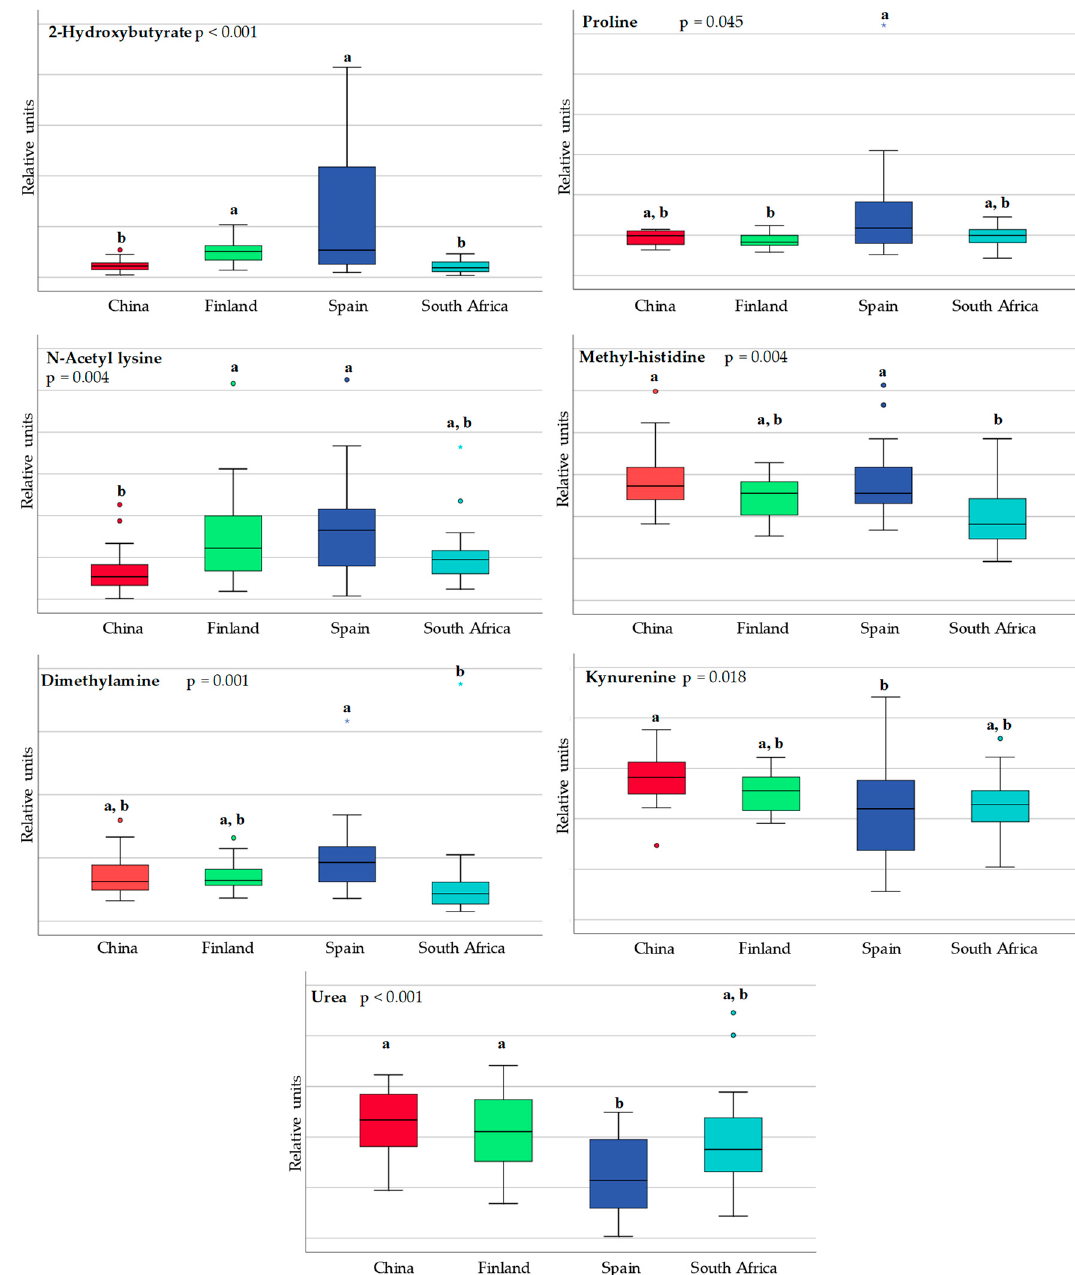
Figure 3. Box and whisker plot showing statistical significant differences in amino acids and derivatives in breast milk obtained from China (red), Finland (green), Spain (blue) and South Africa (pale blue). Data are expressed in relative units. Each bar represents the smallest observation, lower quartile ( Q1 ), median, upper quartile ( Q3 ) and largest observation. Differences among countries were calculated using the Kruskal-Wallis test. Unlike letters indicate statistically significant differences among countries. Circles and stars indicate outlier data.